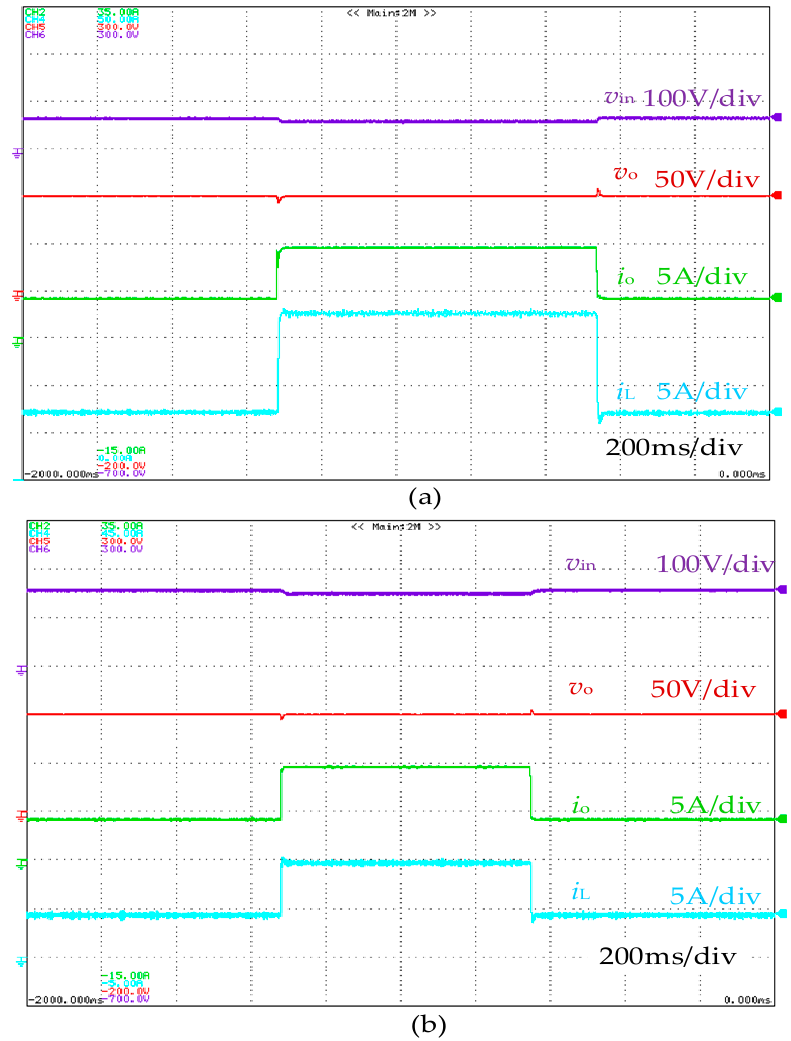
Figure 9. Experiment results of the dynamic test: ( a ) v in < v o (boost mode) and ( b ) v in > v o (buck mode) .